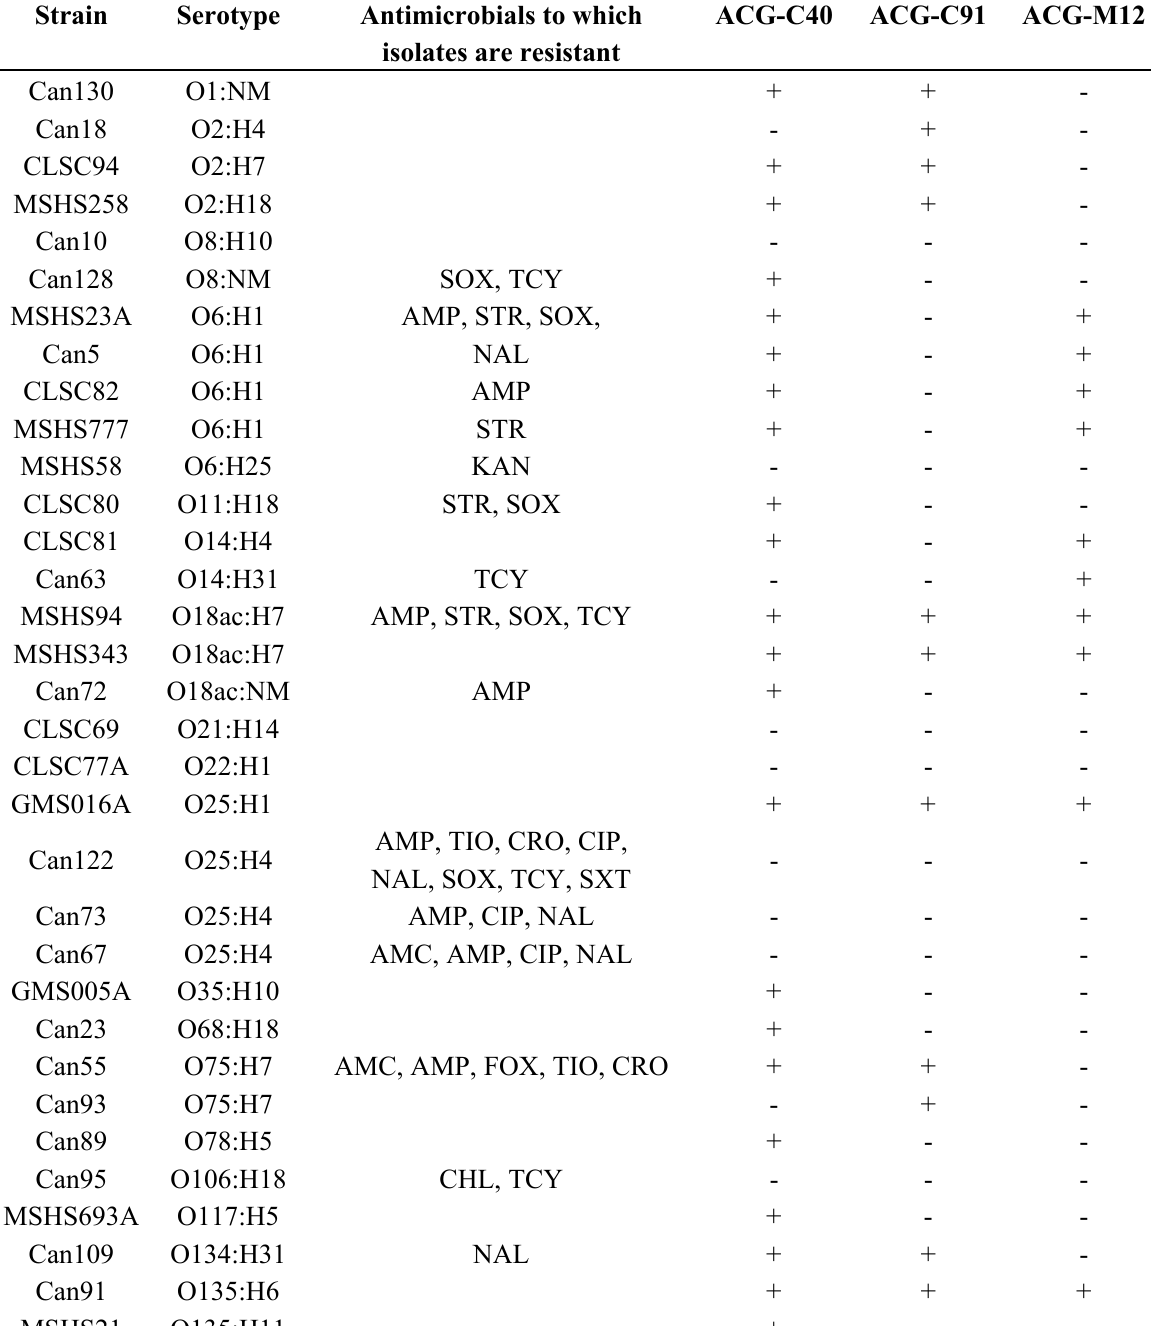
Table 1. List of UTI E. coli forming biofilms, their serotypes, respective antimicrobials resistances and sensitivity to the three isolated phages ACG-C91, ACG-C40 and ACG-M12. AMC = Amoxicillin/Clavulanic acid; AMP = Ampicillin; FOX = Cefoxitin; TIO = Ceftiofur; CRO = Ceftriaxone; CHL = Chloramphinicol; CIP = Ciprofloxacin; KAN = Kanamycin; NAL = Nalidixic acid; STR = Streptomycin; SOX = Sulfisoxazole, TCY = Tetracycline; SXT = Sulphamethoxazole/Trimethoprim. + symbolises sensitivity to phage; - resistance to phage; nd, not